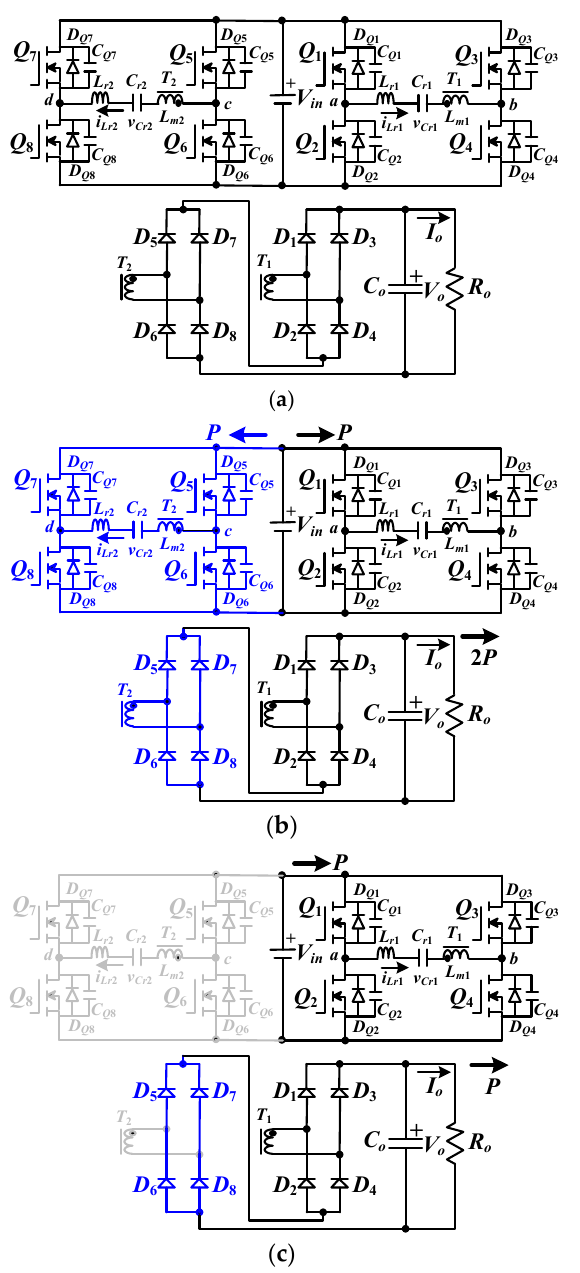
Figure 1. Circuit configurations of the developed dc/dc converter: ( a ) The proposed circuit structure; ( b ) at low voltage input range; ( c ) at high voltage input range.